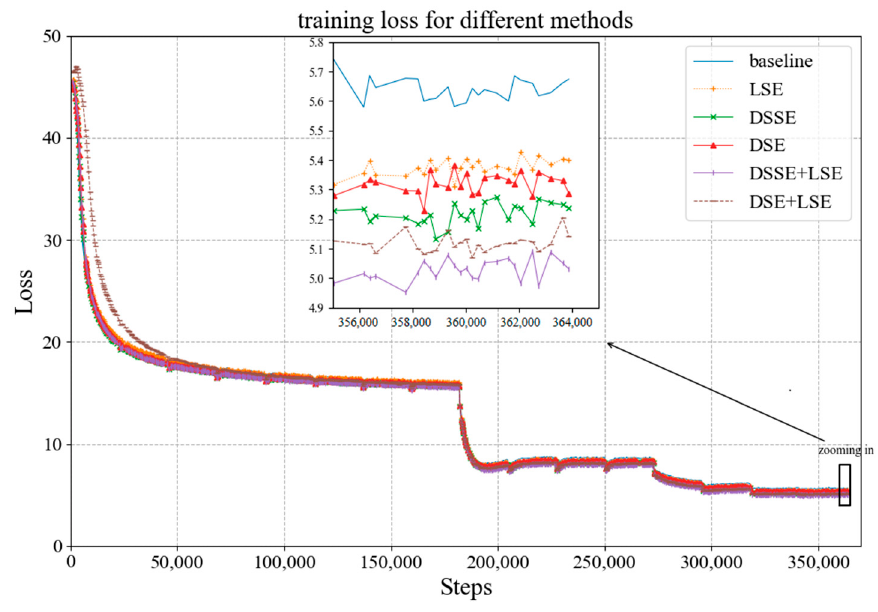
Figure 9. Training loss curves of the models with different SE modules.